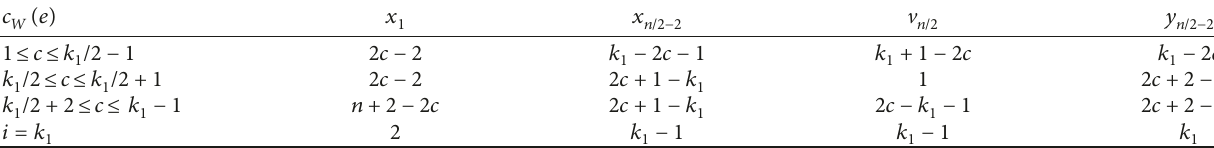
u c is odd. c c , when